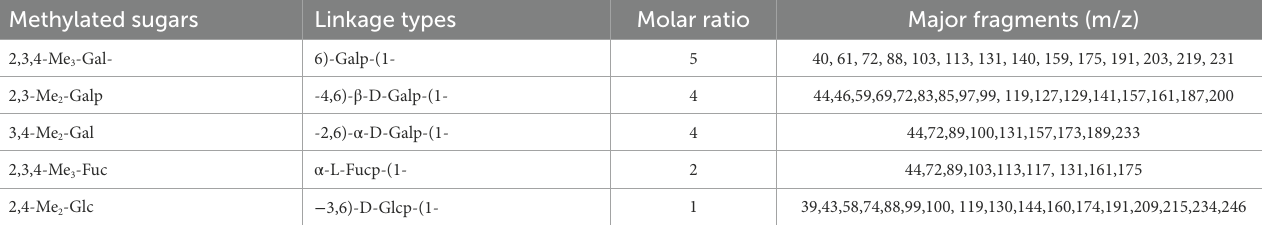
TABLE 5 Monosaccharide units present in the Galactose Rich Heteropolysaccharide (synthesised by endophytic fungi Mucor sp. HELF2) are represented here with their respective sugar linkages and molar ratios. Methylated sugars